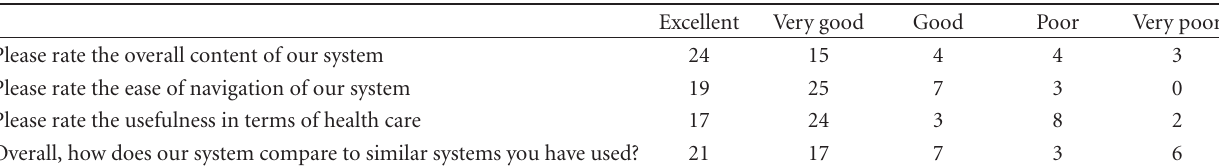
Table 1: Usefulness results.